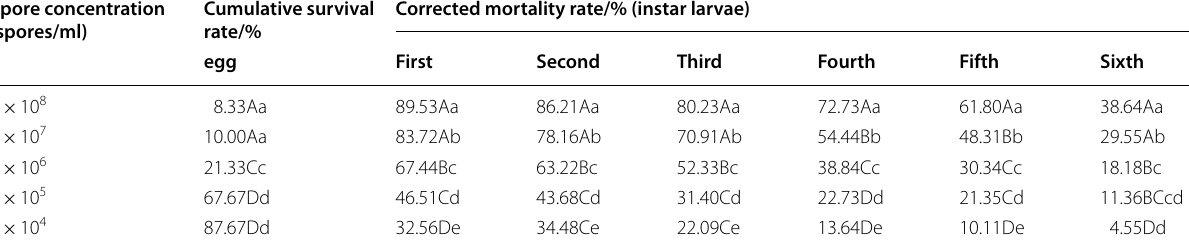
Table 2 Corrected mortality for 1–6 larval instars Spore concentration (spores/ml)